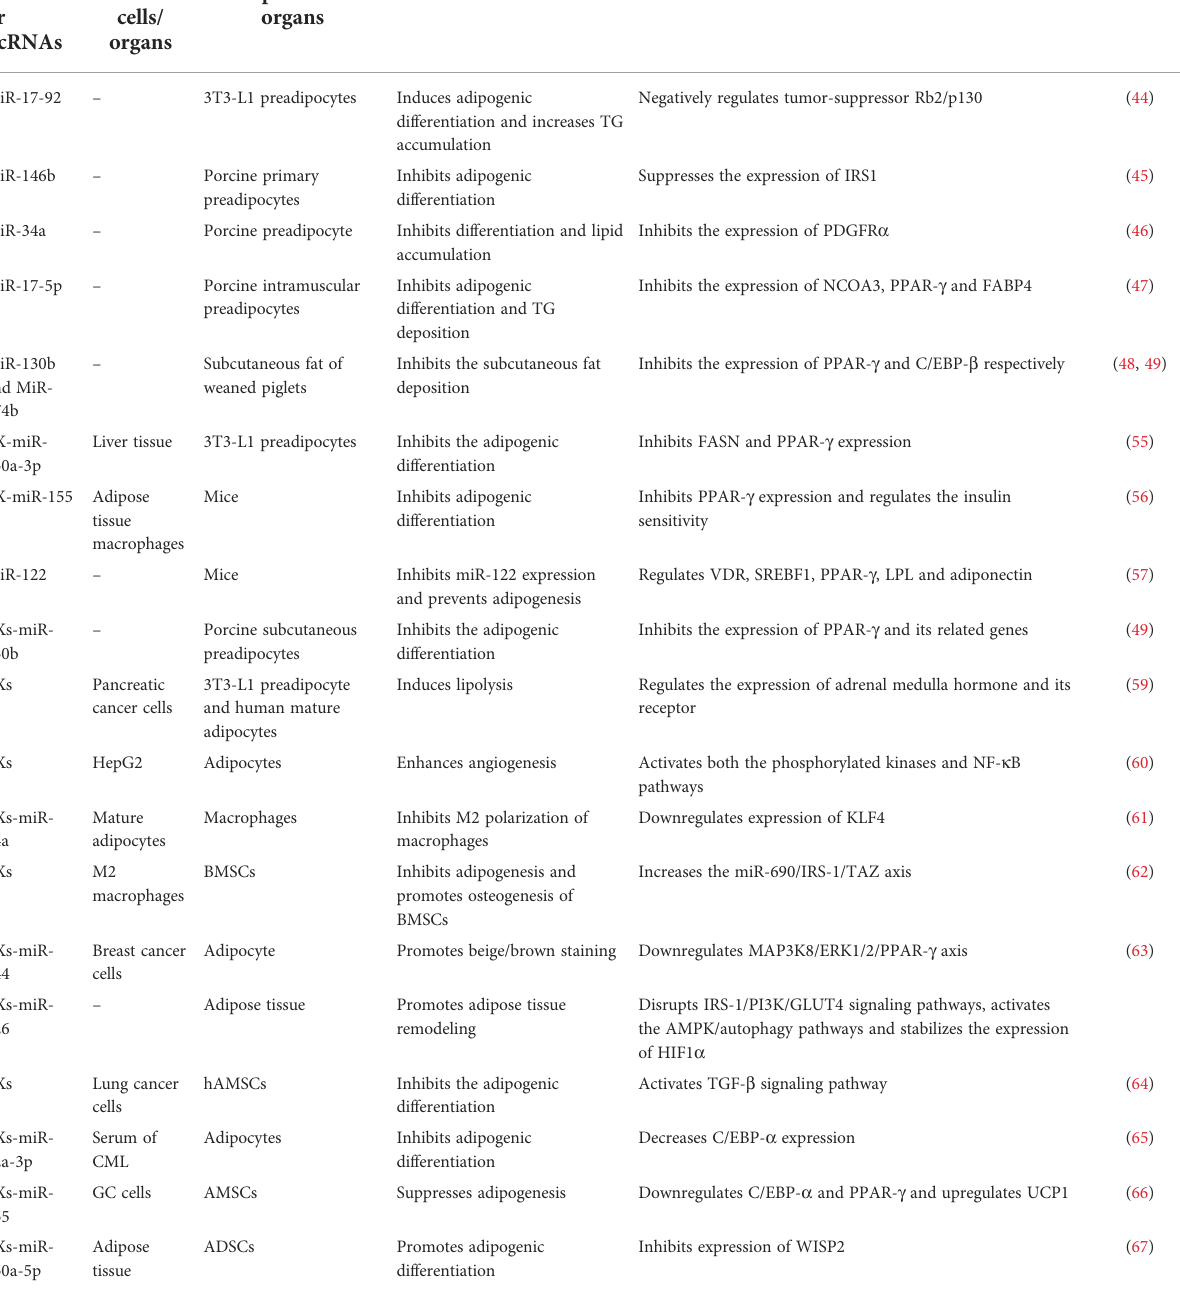
TABLE 1 EXs and/or miRNAs regulate adipogenic